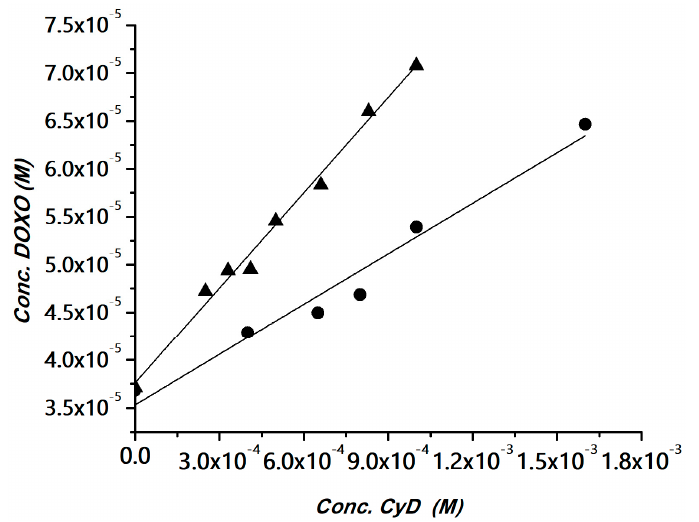
Figure 3. DOXO solubility (phosphate buffer, pH 7.4) versus the amount of HAH β CyD ( ▲ ) or HAL β CyD ( ● ) (reported as CyD cavity concentration).